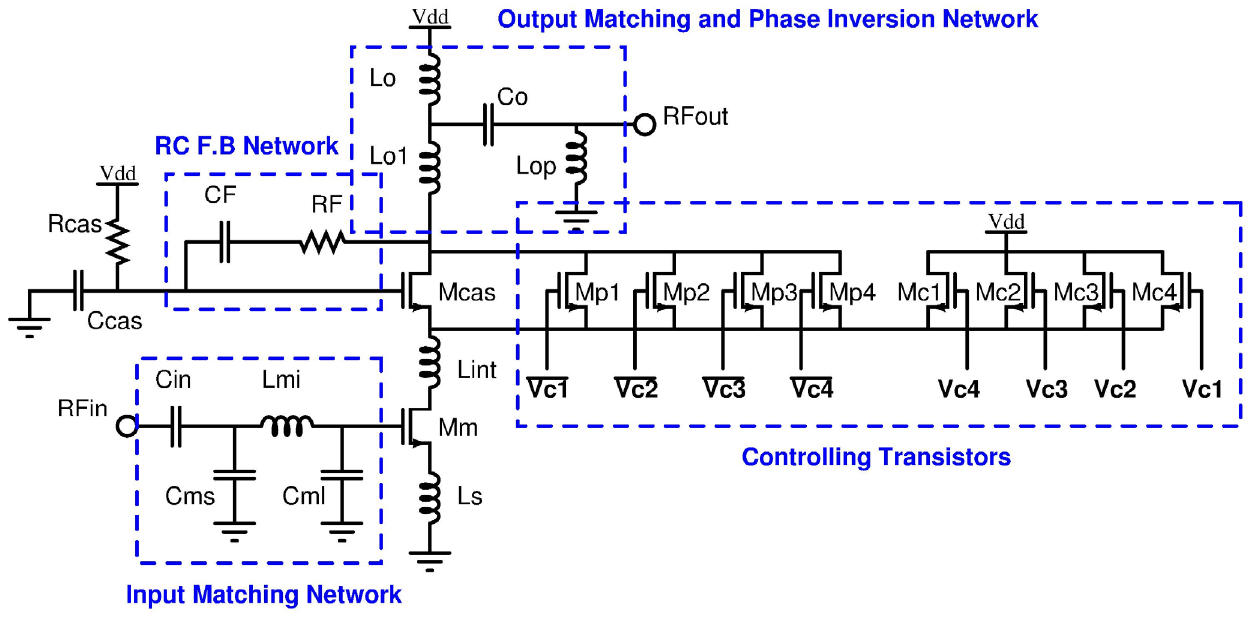
Figure 1. Circuit schematic of a single ended architecture for the proposed 4 bits digitally controlled VGA.